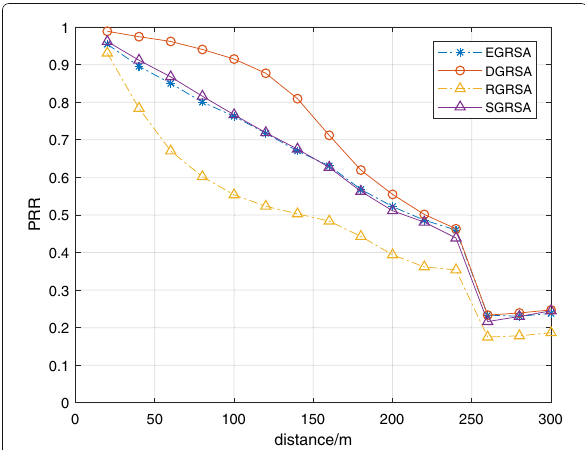
Fig. 21 The PRR of DGRSA when the number of VUEs is 900 in the jam scene. The packet reception ratio (PRR) curve changes with distance when jam areas are areas 1, 3, 6, 12, and 13 and the number of vehicle user equipments (VUEs) is 900. Four geo-based algorithms, namely random geo-based resource selection algorithm (RGRSA), sensing geo-based resource selection algorithm (SGRSA), the proposed enhanced geo-based resource selection algorithm (EGRSA) and the proposed dynamic geo-based resource selection algorithm (DGRSA), are compared in this figure. The line with red circles represents the proposed DGRSA. The line with blue stars represents the proposed EGRSA. The line with purple triangles represents the SGRSA. The line with yellow triangles represents RGRSA